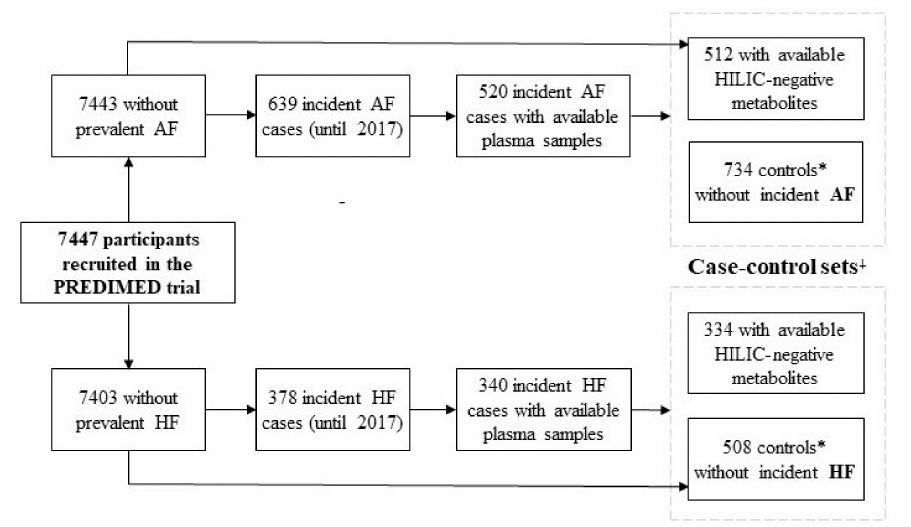
Figure 1. Flowchart of the study subjects. * Incidence density sampling with replacement was used as the control sampling method. † Case–control sets matched by age, sex, and recruitment center. Abbreviations: AF: atrial fibrillation; HF: heart failure; HILIC: hydrophilic interaction liquid chromatography; PREDIMED: Prevenci ó n con Dieta Mediterr á